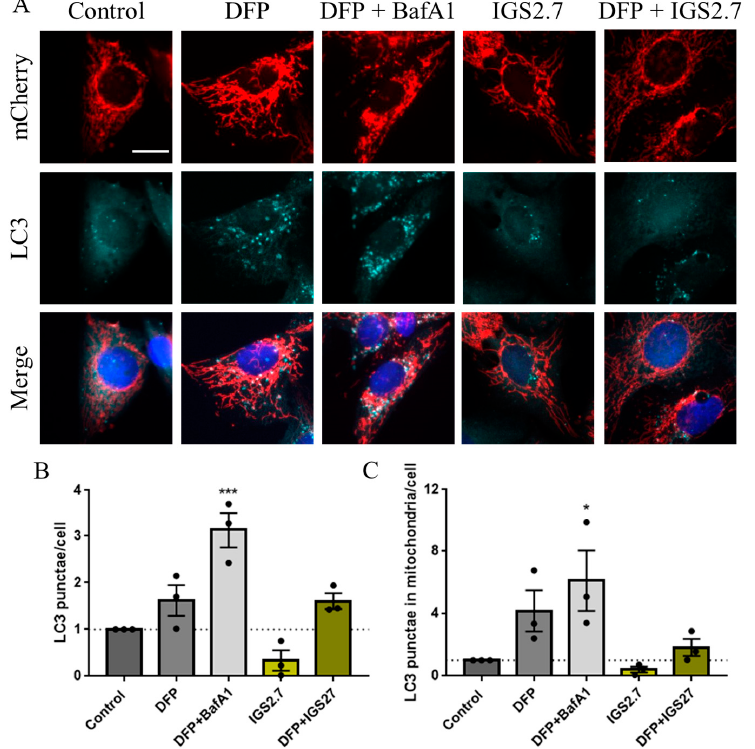
Figure 3. IGS2.7 reduced LC3 punctae and LC3 co-localization with mitochondria in U2OS-iMLS cells. ( A ) Immunostaining for LC3 and quantification of ( B ) LC3 punctae and ( C ) LC3 punctae in mitochondria after the treatment with IGS2.7 25 µM, DFP 1 mM for 24 h and BafA1 for the last 2 h. Data represent the mean ± SEM of three independent experiments (significance was determined by one-way ANOVA followed by Dunnett’s multiple comparison test to control, where *** p < 0.001, * p < 0.05): Scale bar = 20 µm.